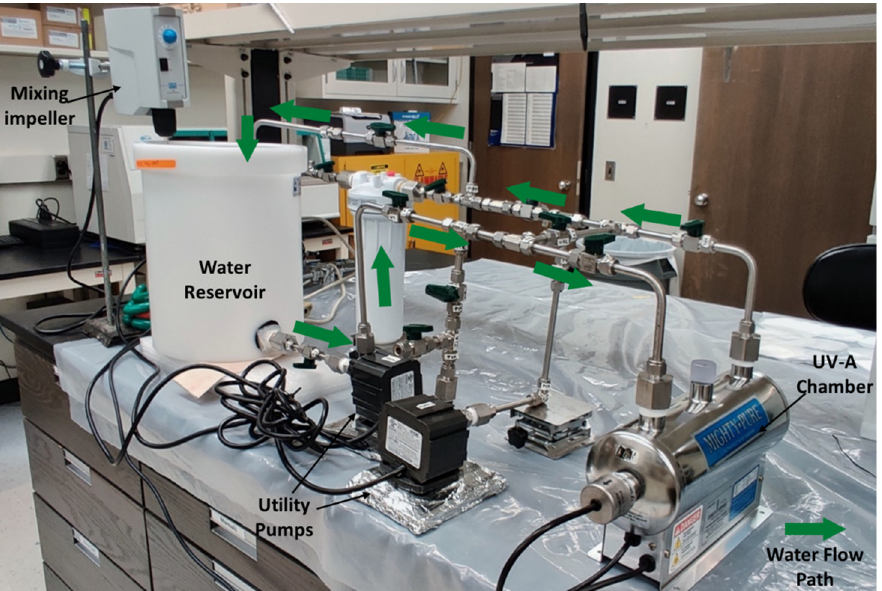
Figure 1. A picture of the benchtop water disinfection system built for processing 15.14 liters (4 gallons) per minute of water. The setup is assembled from commercially available components,